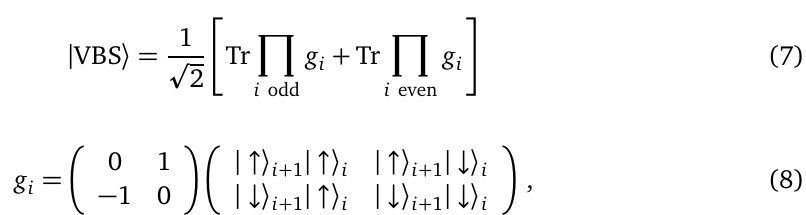
Figure 9: (a) Excitation energy from the S tot = 1 ( ε a single plaquette extracted from the diagonal ladder [ Fig. 1(c) ] . A spin-singlet is formed between sites 1 and 4 in the S tot = 1 sector. (b) Spin-spin correlations in a single plaquette as a function of α